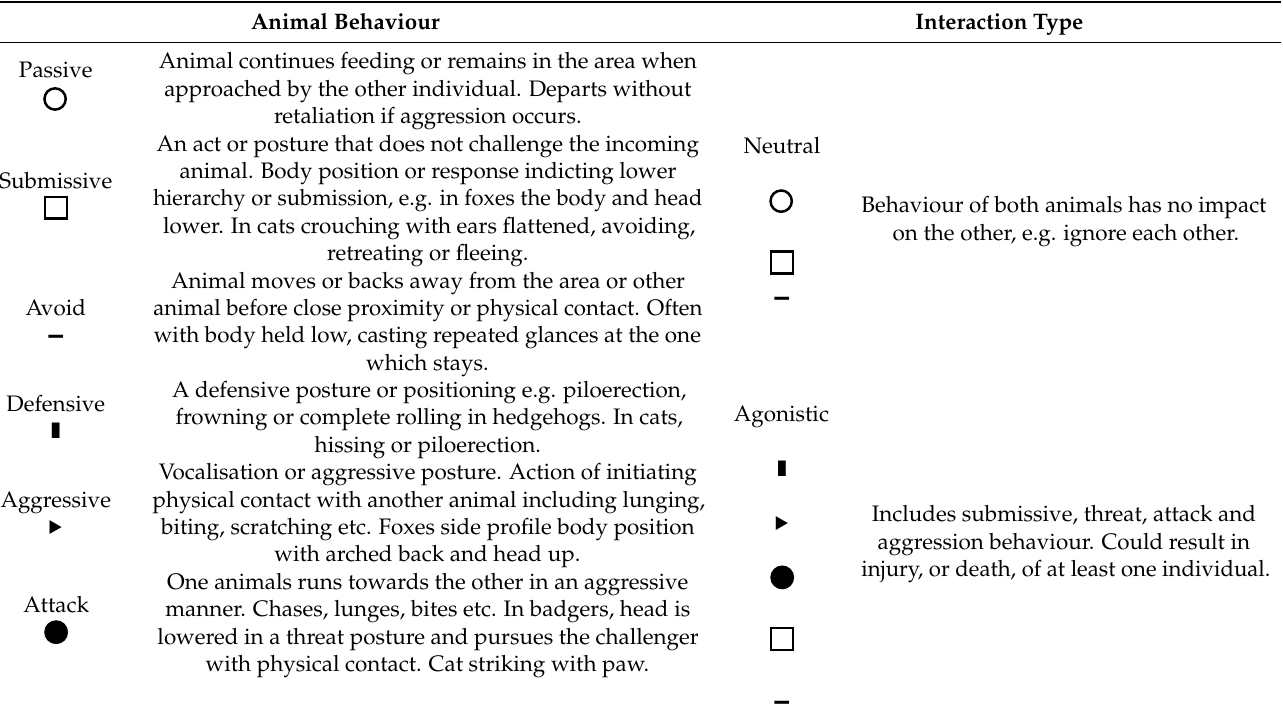
Table 1. Behavior categories and types of interaction based on analysis of encounters between four species of urban mammal—Western European Hedgehog ( Erinaceus europaeus ), Eurasian badger ( Meles meles ), Red fox ( Vulpes vulpes ), and domestic cat ( Felis catus ). Symbols represent each behavior and how they relate to the two broad interaction types.